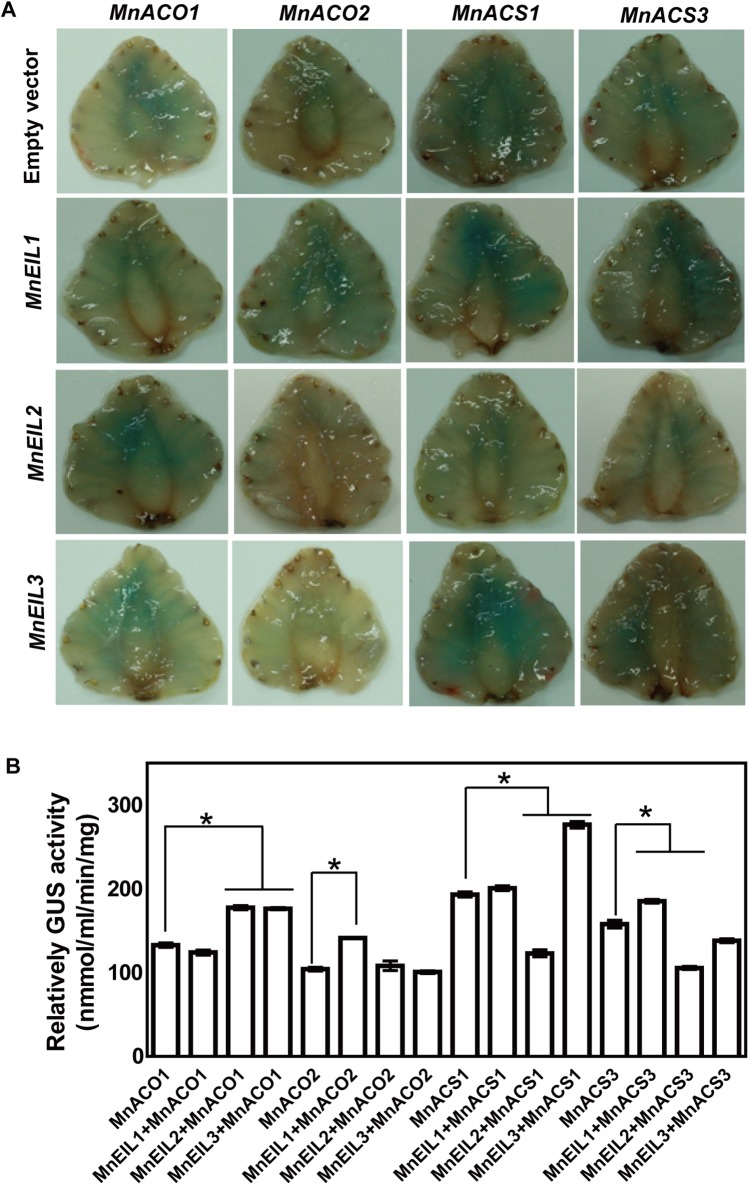
In vivo interactions of MnEIL3 with ethylene biosythetic genes promoters.(A) GUS staining of the injected strawberry fruit. (B) The detection of GUS activities. Data are means ± SEs (n = 3). Significant differences (P < 0.05) are marked with asterisks.